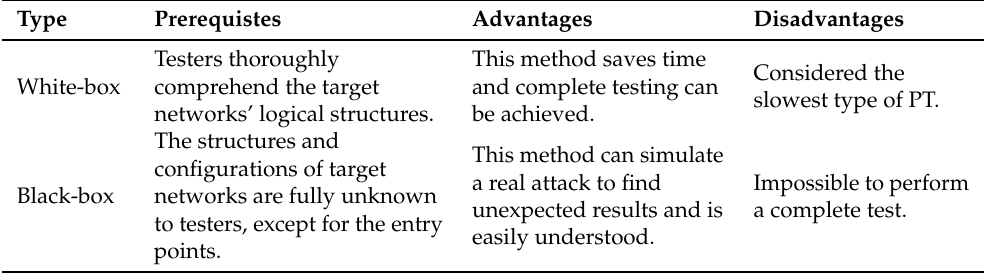
Table 1. The Classification of Penetration